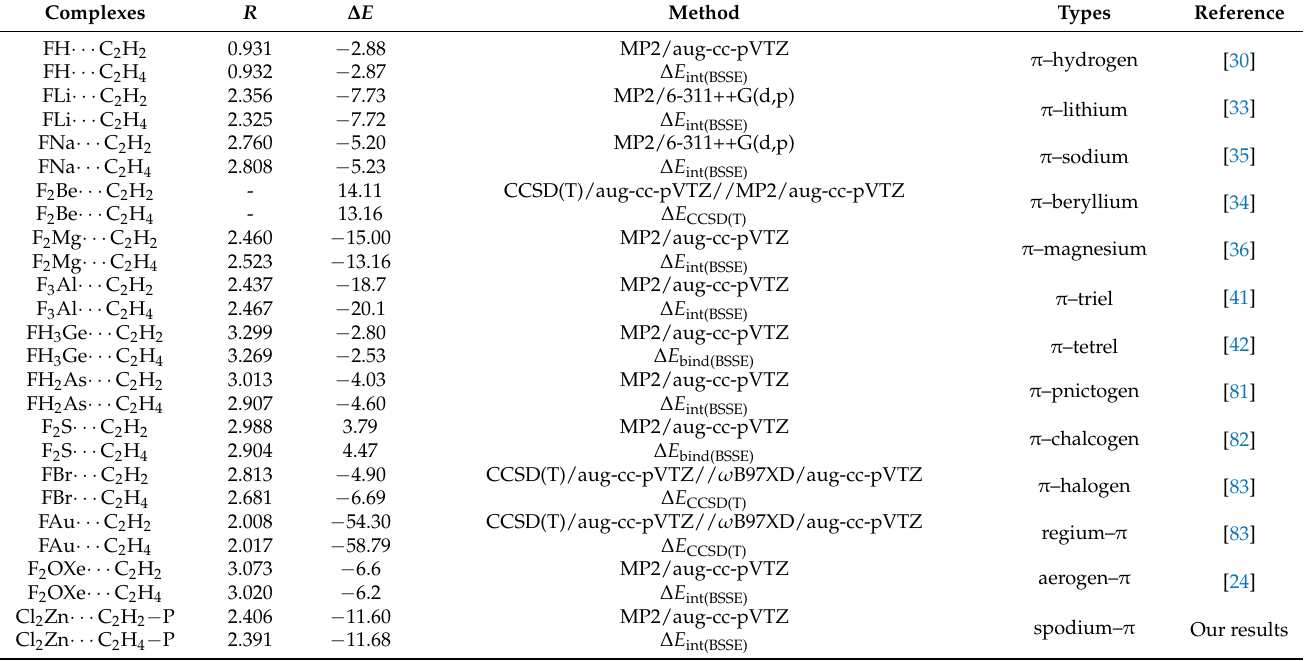
Table 5. Binding distance ( R in Å) and interaction energy ( ∆ E in kcal/mol) for some interactions, including π systems. Method Types